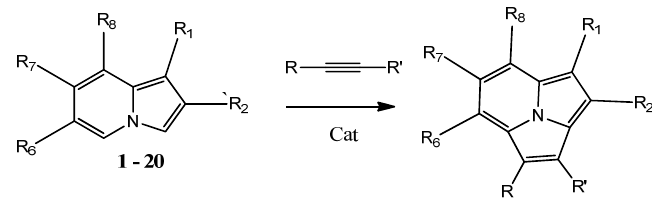
Scheme 4. Symthesis of cyclazines from indolizines (Table 1). Table 1. Substituents, reaction conditions and yields of reactions of indolizines with substituted acetylenes giving cyclazines (Scheme 4).